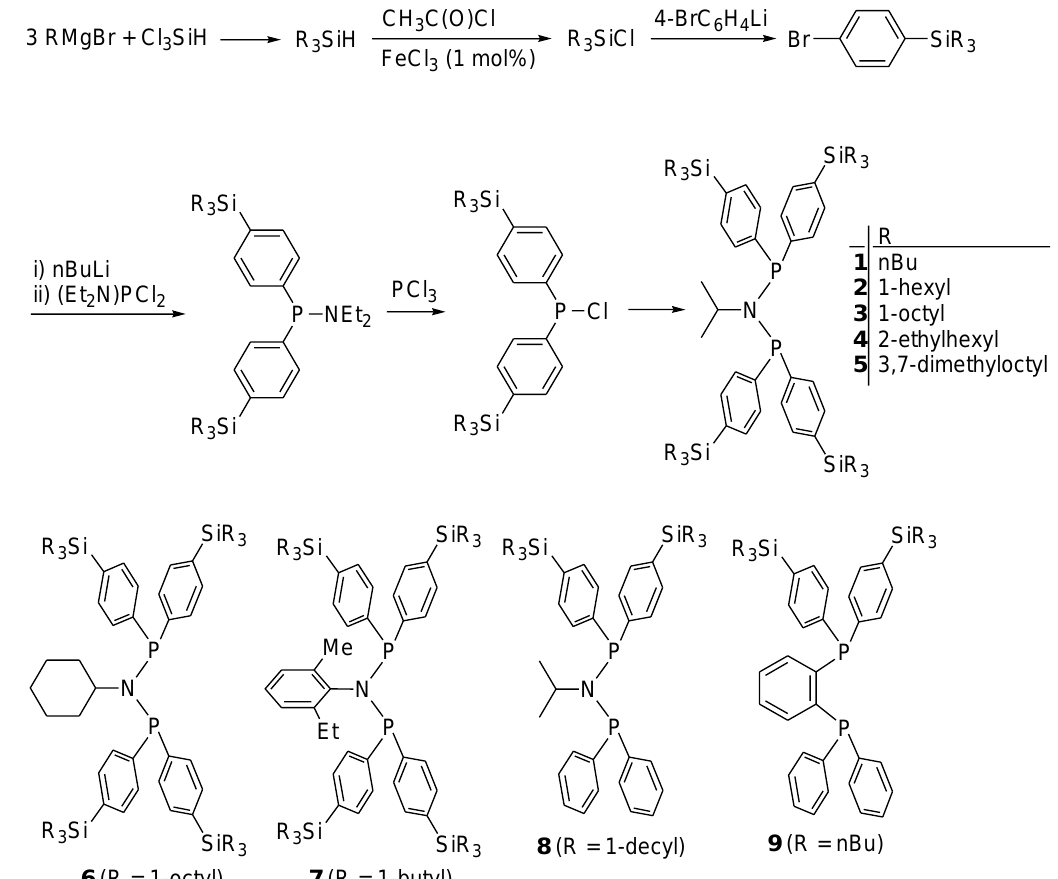
Scheme 2. Synthesis of bis (phosphine) ligands for ethylene tetramerization